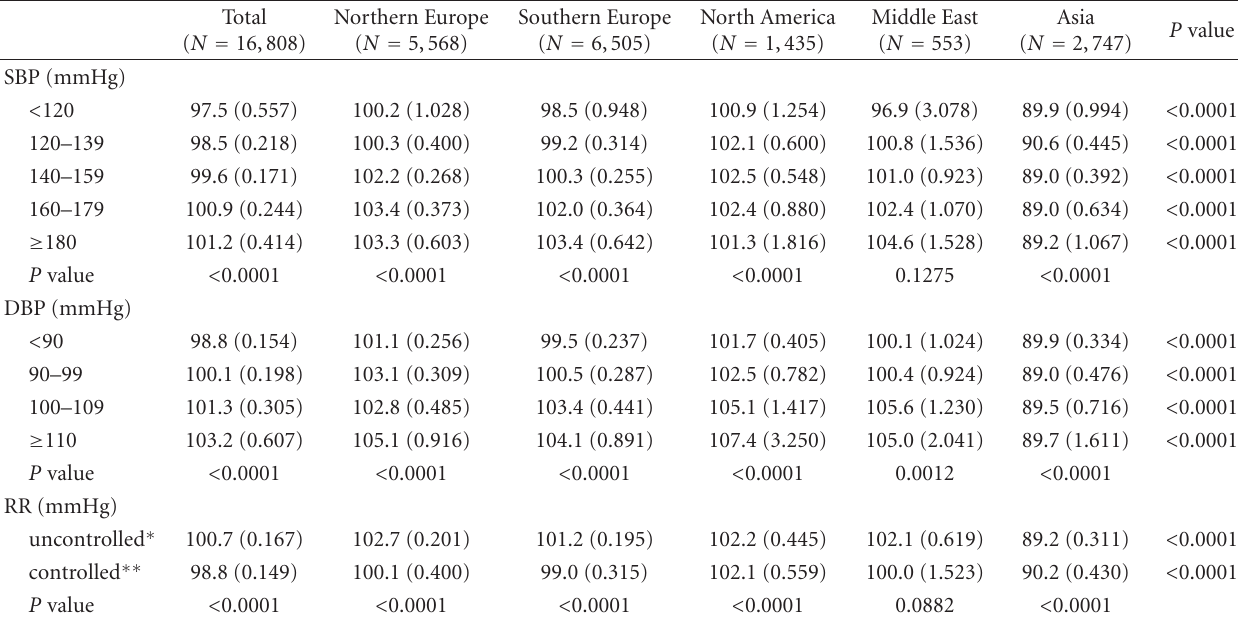
Table 3: Blood pressure and WC (cm ± SD, adjusted for age,